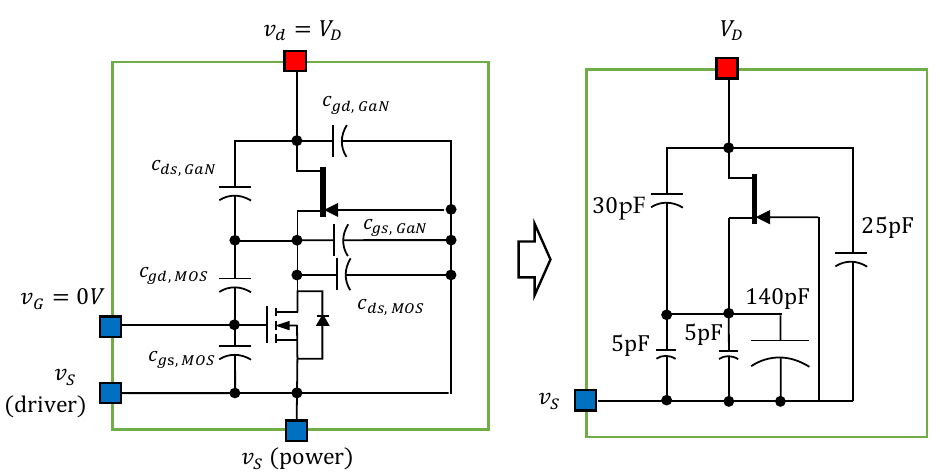
Figure 4. The parasitic capacitances of conventional cascode GaN HEMT power module.